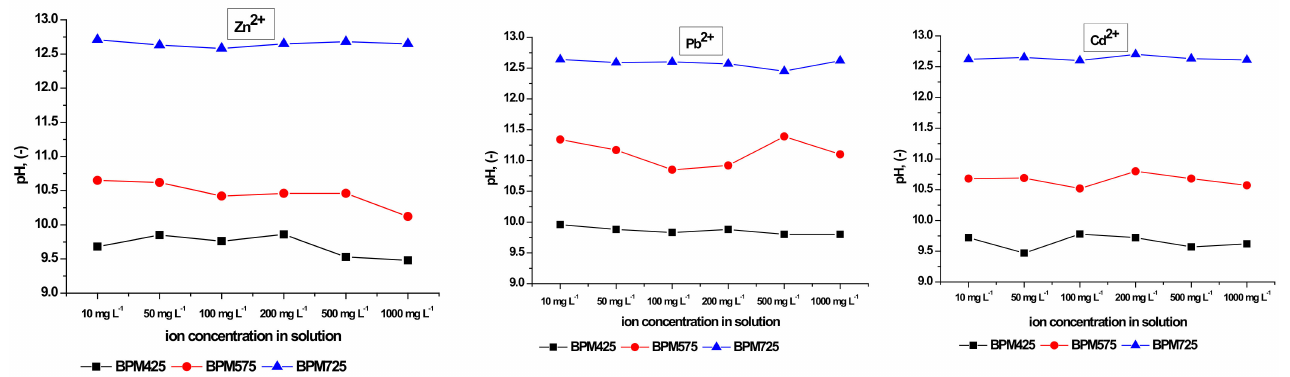
Figure 4. The pH values after the process of sorption was